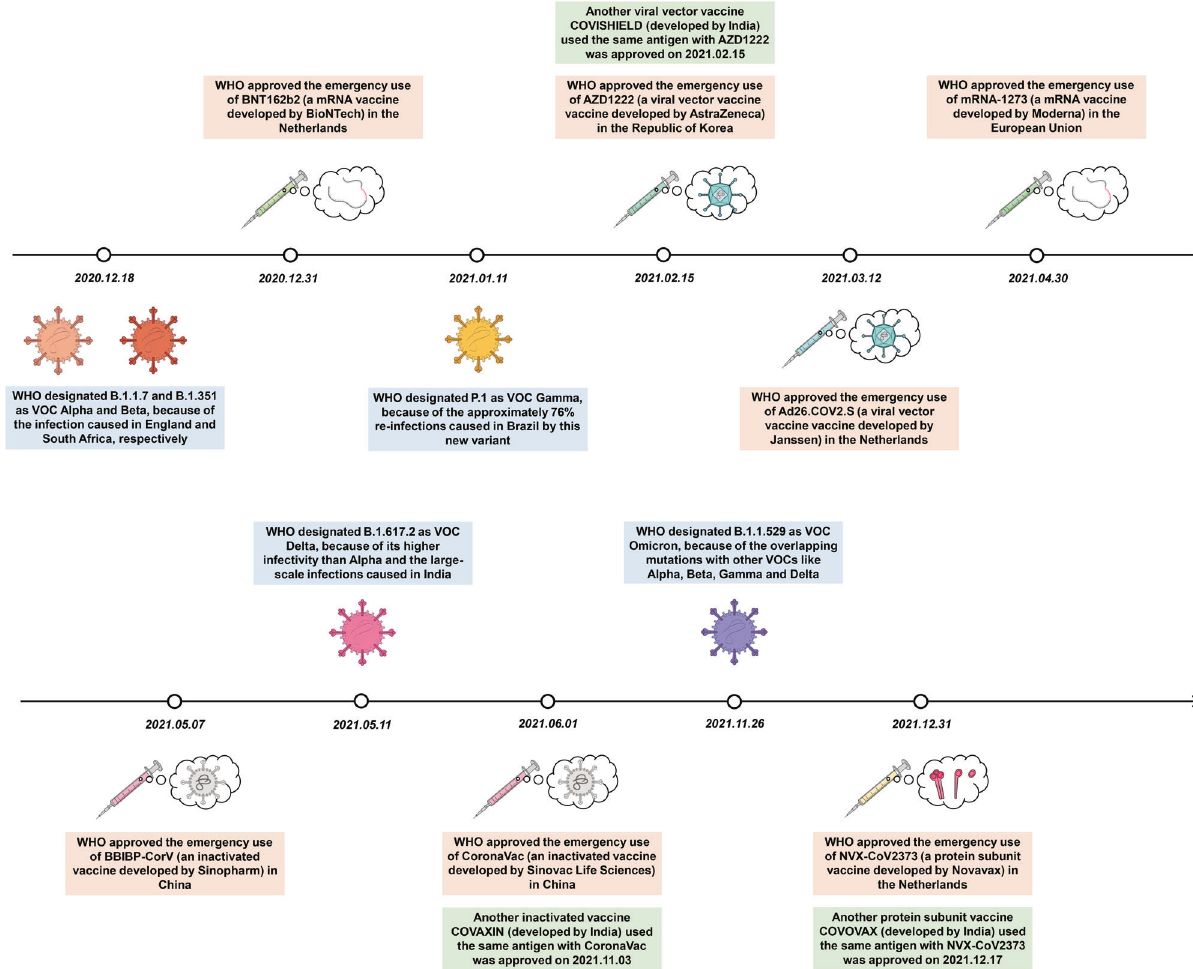
Fig. 5 A timeline of critical events in the COVID-19 vaccine development progress. WHO has approved the emergency use of ten vaccines (including three India vaccines, COVISHIELD, COVAXIN, and COVOVAX). Vaccination plays a critical role in protecting people from SARS-CoV-2 infections. However, the appearance of VOCs brought big challenges to the ef fi cacy of approved COVID-19 vaccines. These events were summarized and displayed in the form of a